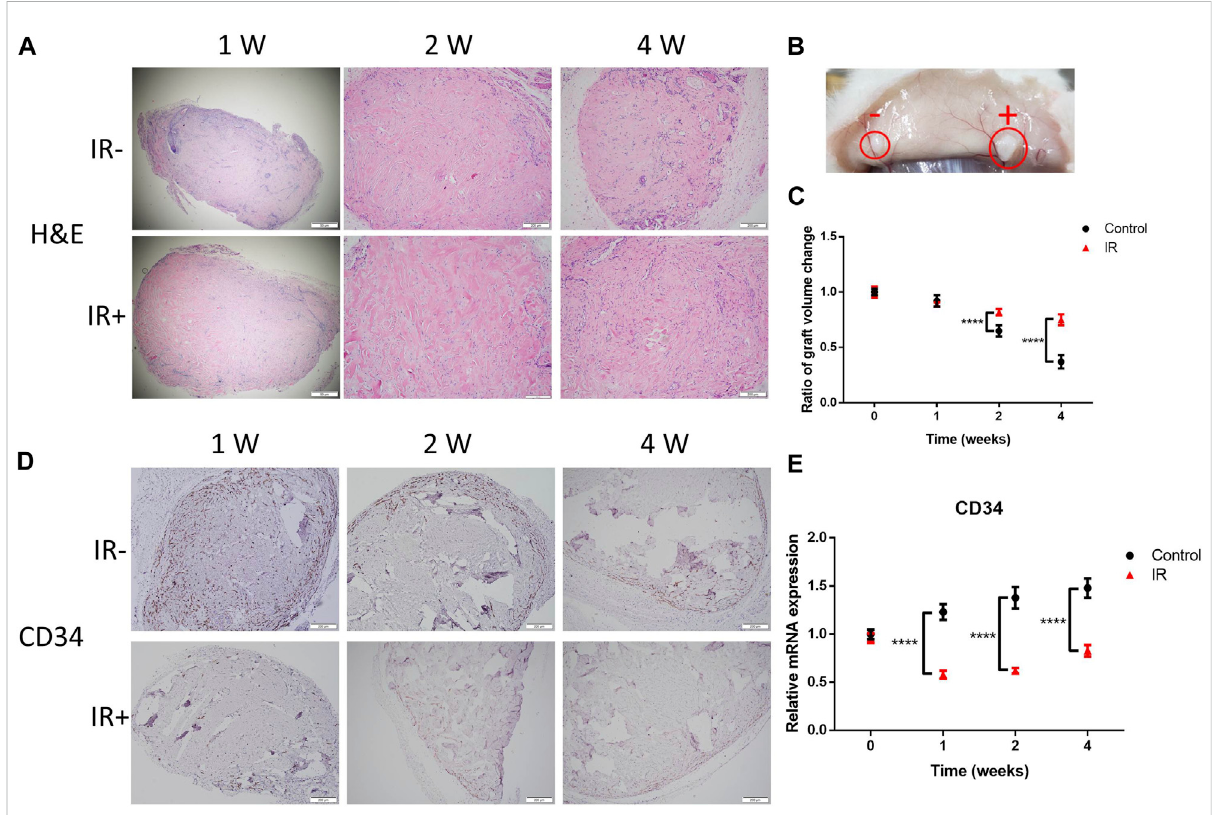
FIGURE 2 Irradiation (IR) induced destruction of the microvasculature and tissue loss. (A) Representative images showing H&E staining, (B) a morphologicalcomparisonat4weeksafterIRand (C) acomparisonofthegraftvolumeratio.Imagesfrom6representativerandom fi eldsareshown. The scale bars represent 200 µm except for the scale bar of 1 W in (A) , which represents 50 µm. (D) Graft sections were stained for CD34 for IHC analysis. Six samples per group were examined, and representative images are shown (scale bar represents 200 μ m). (E) Comparison of the CD34 levels in the two groups of grafts. Data from 3 experiments were combined and are presented as the mean ± SD; n = 6; ****, p <